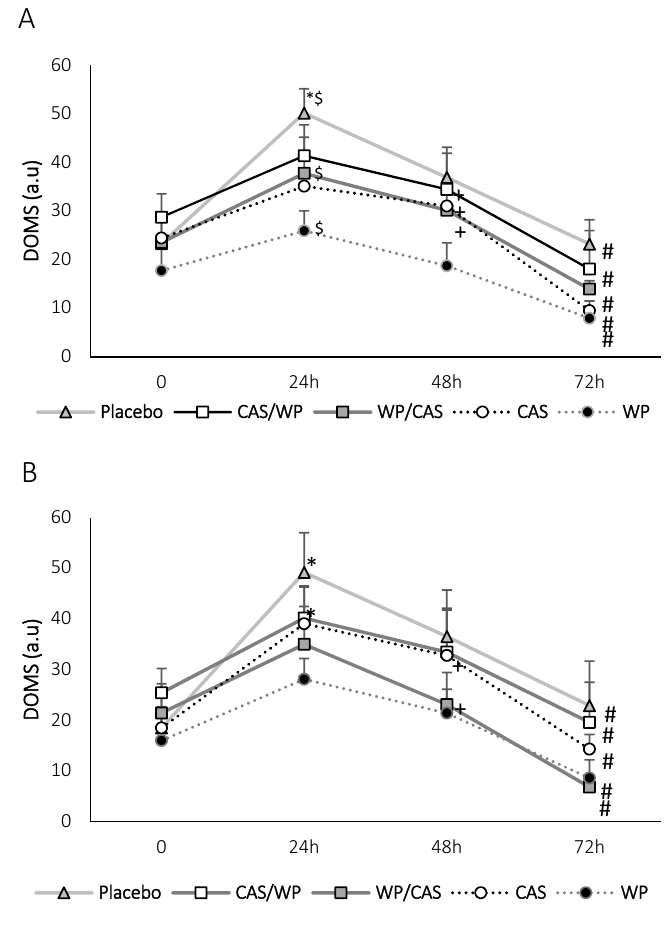
Figure 2. Delayed Onset Muscle Soreness (DOMS) post-treatments. ( A ) Down the stairs and ( B ) sitting. 0 immediately, 24 h, 48 h, and 72 h after the exercise protocol. a.u: Arbitrary Units. Values expressed as the mean ± SEM. * Significant differences between 0 h and 24 h, $ significant differences between PLA–WP/CAS and PLA–WP, # significant differences between 24 h and 72 h, and + significant differences between 48 h and 72 h. Significance level considered p < 0.05. n = 10. WP: Whey protein, CAS: casein. WP/CAS: 80% whey protein/20% casein. CAS/WP: 80% casein/20% whey protein. PLA: Placebo.